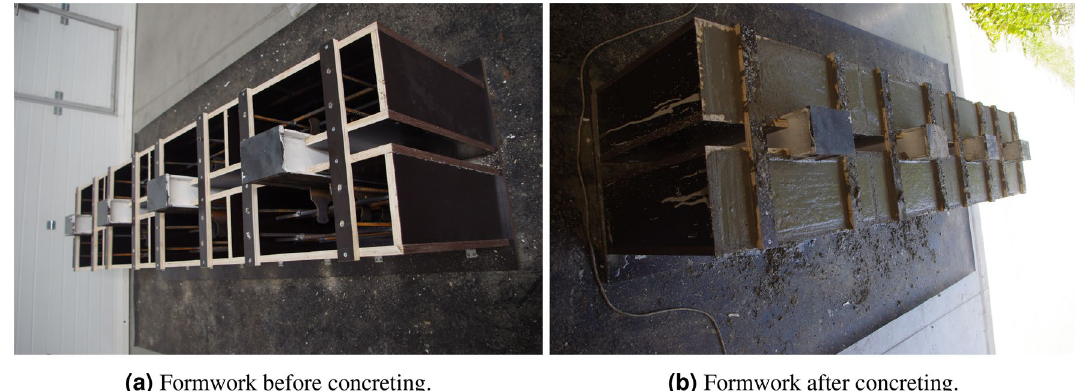
Figure 4. Specimens preparations for the push-out tests.